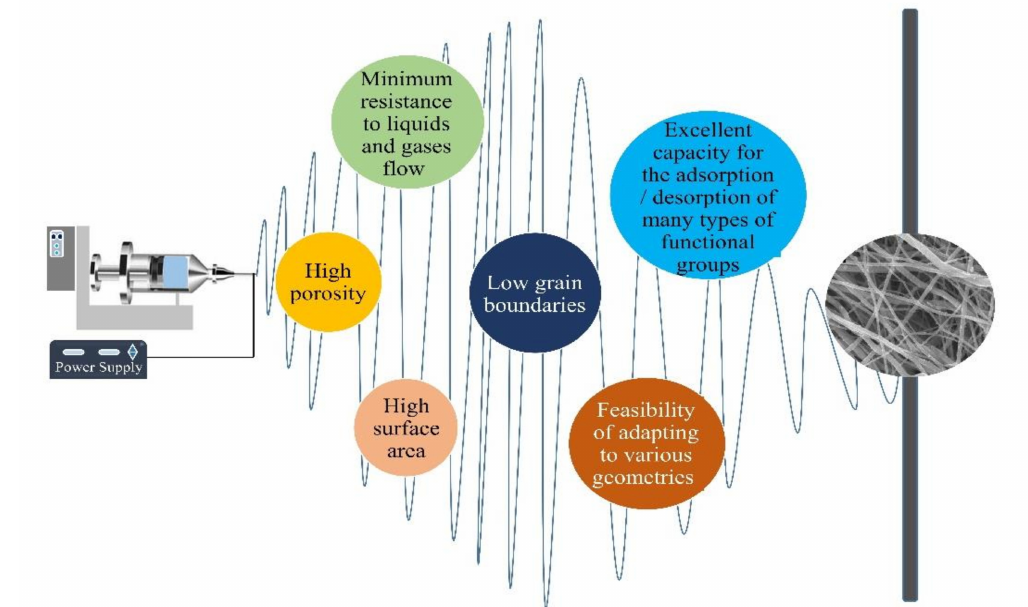
Figure 1. Properties of electrospun